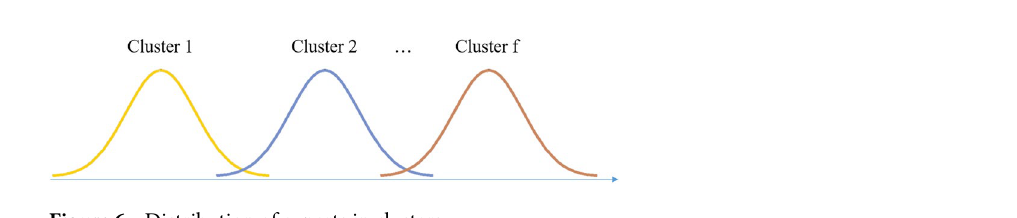
Figure 5. Development of design concept evaluation experts.